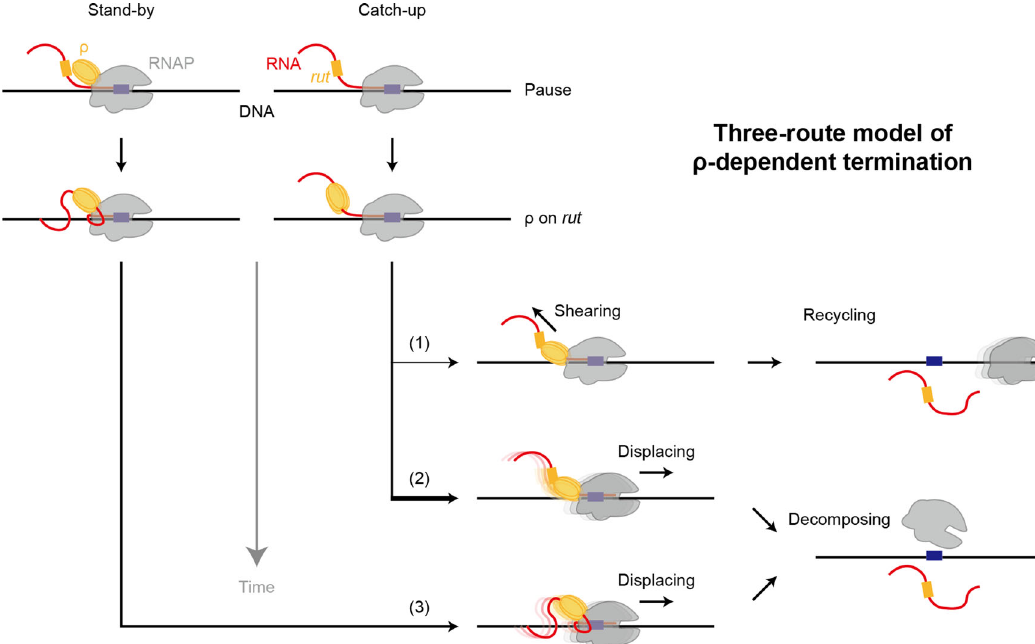
Fig. 7 The three-route model of ρ -dependent termination. Three kinetically different routes of transcription termination are operating with a single terminator in our model for ρ -dependent termination, whereas all previous models assume a single path. (1) Catch-up recycling termination. The fastest termination route is taken by catch-up ρ , which binds nascent RNA at a rut site, translocates down on RNA, and catches up with RNAP that is pausing at a termination site. Only RNA, not RNAP, is released, and post-terminational RNAP recycles on DNA for 1D reinitiation (like in most intrinsic termination 15 – 17 , which is ρ -independent but RNA hairpin-dependent). (2) Catch-up decomposing termination. If the fi rst, fastest termination fails, the second termination route can be followed by catch-up ρ . Transcription complex decomposes in a step as both RNA and RNAP depart DNA. This second-route termination by catch-up ρ for decomposing always occurs much later than the fi rst-route termination for recycling. (3) Stand-by decomposing termination. The slowest termination route is usually pursued by stand-by ρ , which pre-binds RNAP, moves along DNA with RNAP, and stands by for binding a rut site emerging out of RNAP. This termination results in one-step disassembly of the transcription complex. Interestingly, stand-by ρ presumably binds RNAP earlier than catch-up ρ but tends to achieve termination not so much earlier. While the catch-up decomposing termination route (2) is the most frequent in all terminators, relative frequencies of the other routes (1) and (3) depend on